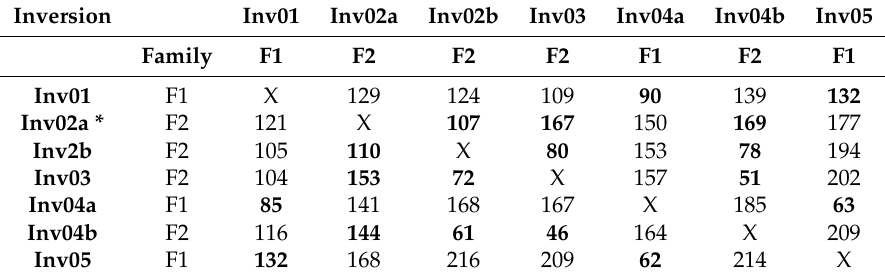
Figure 7. Methods for computing the average distance between two meshes, illustrating why D AB is slightly different from D BA . Table 2. Average distances (in meters) between pairs of meshes. * is the preferred model presented in Smittarello et al. [16]. Distances in bold are for models belonging to the same